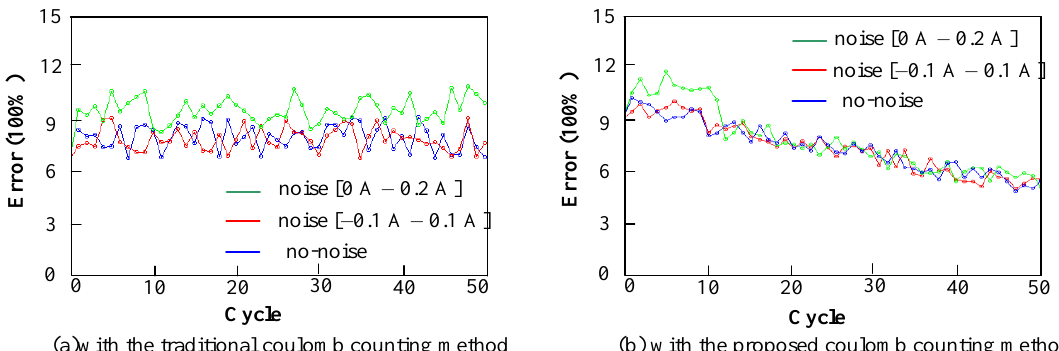
Figure 13. The relative errors in different noisy environments. ( a ) With the traditional coulomb counting method; ( b ) With the proposed coulomb counting